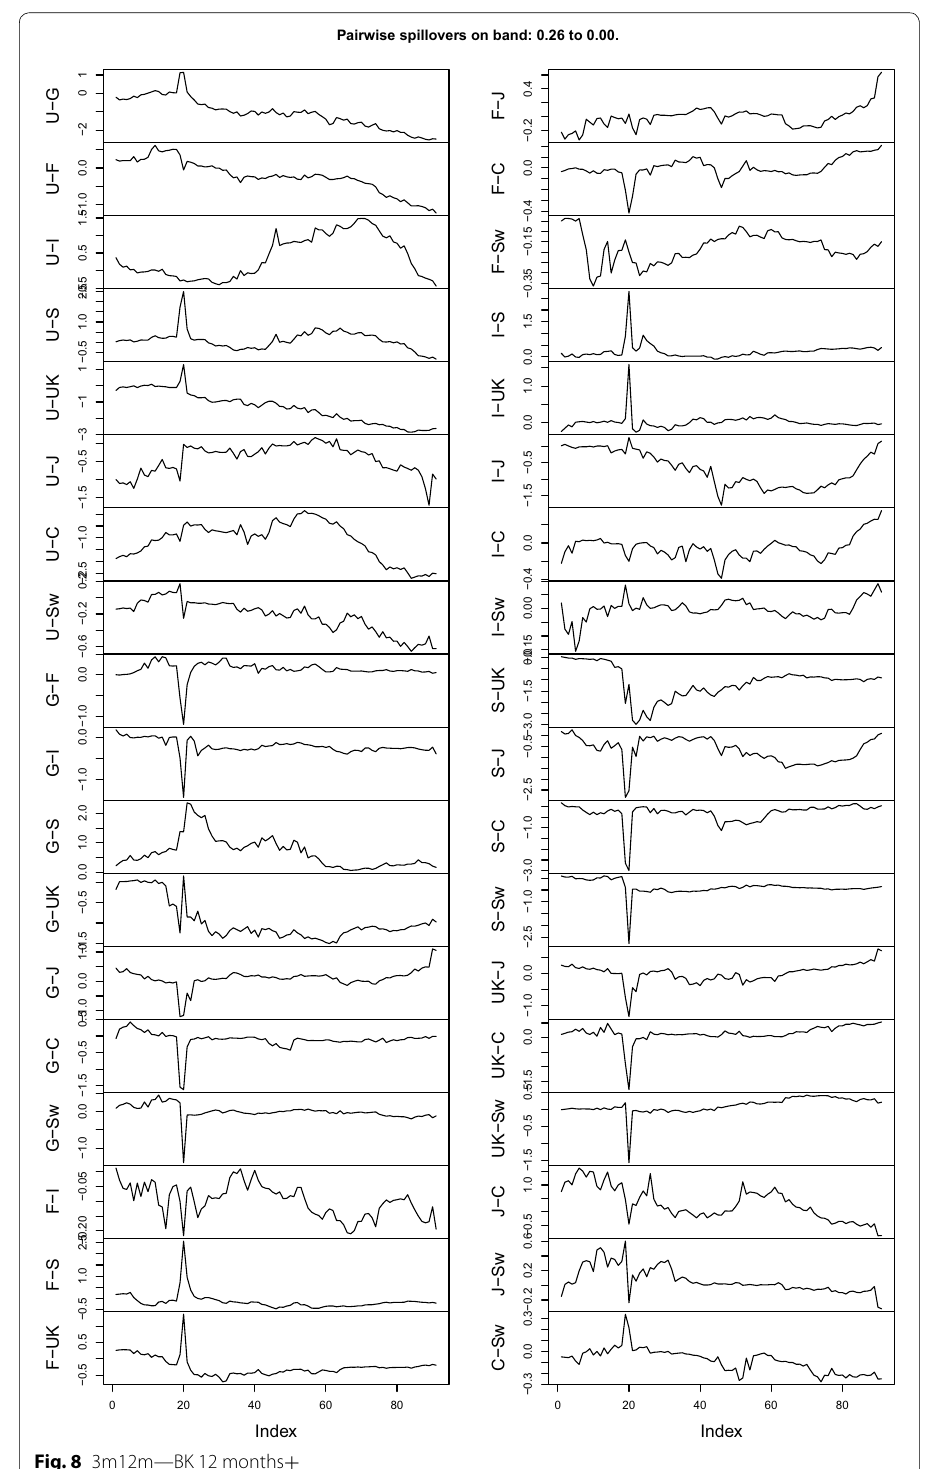
Fig. 8 3m12m—BK 12 months